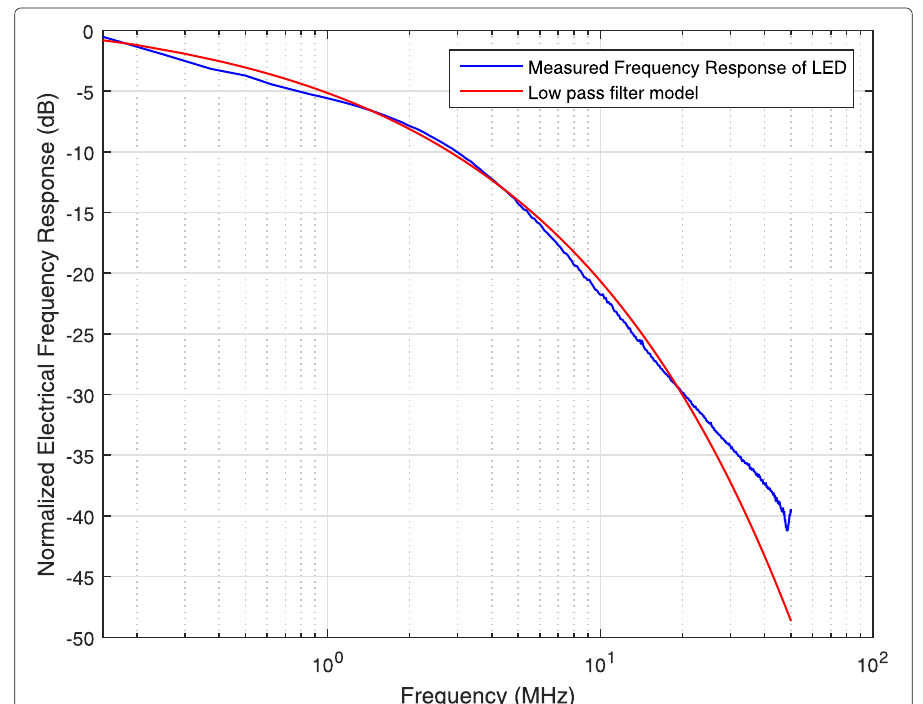
Fig. 6 Frequency response of LED. The frequency response measured by network analyzer at the output of the receiver